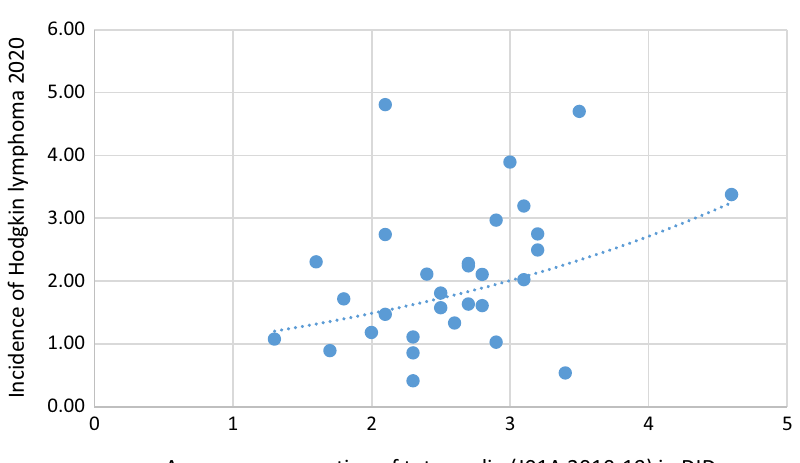
Figure 1. A significant positive association has been found between tetracycline consumption and the incidence of HL